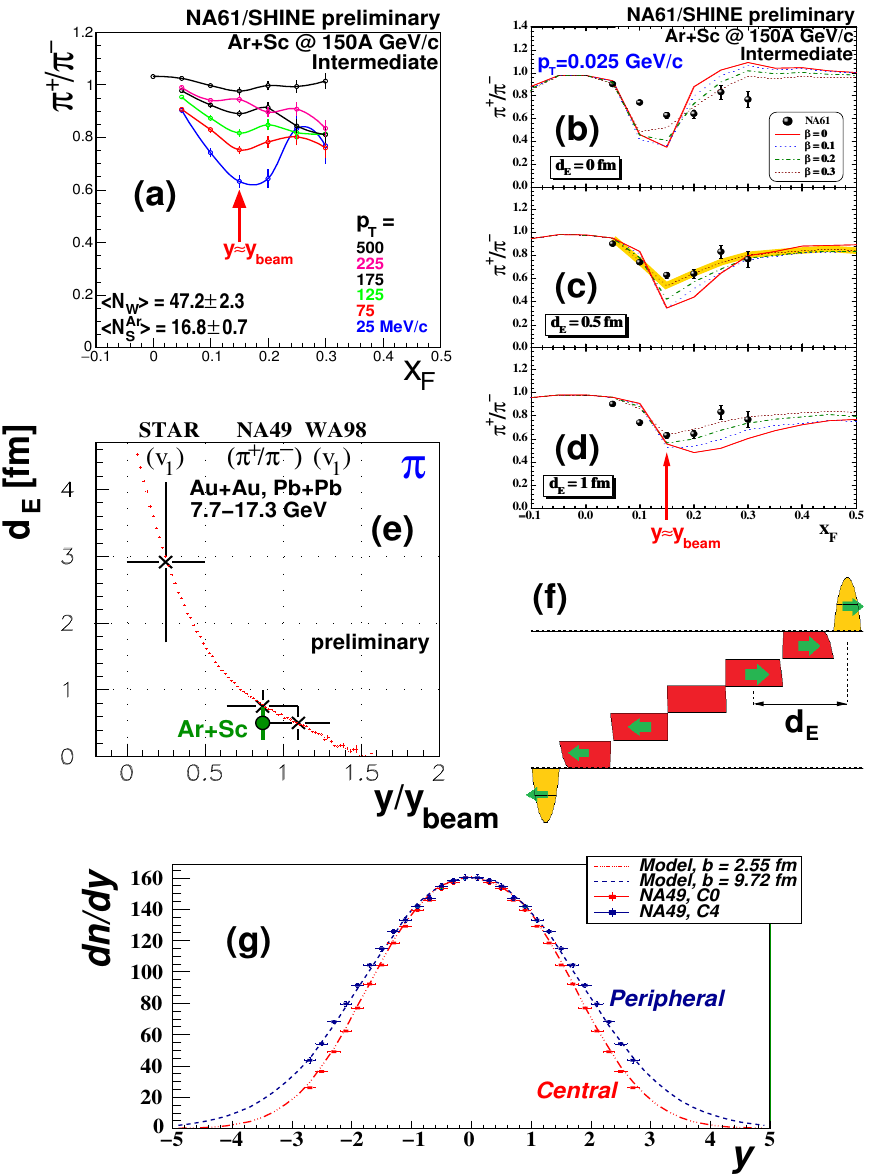
Figure 1. (a) π + /π − ratio in intermediate Ar + Sc collisions [3], (b),(c),(d) π + /π − ratio compared to model simulations described in the text, with the distance between the spectator and the pion at freeze- out set to d E = 0, 0.5, and 1 fm. The optimal description of exp. data is indicated by the yellow line [3]. (e) Dependence of the distance d E on pion rapidity [1], obtained on the basis of exp. heavy ion data [4– 6] and compared to the value presently estimated for Ar + Sc collisions. (f) Sketch of our model [7]. (g) Comparison of our model predictions to experimental π − rapidity spectra in Pb + Pb collisions [8]. For peripheral reactions, both exp. data and model are scaled up by an arbitrary factor (from